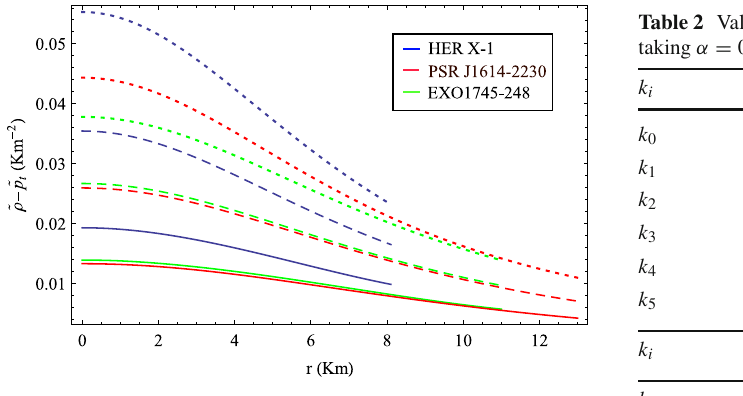
Fig. 14 Radial variation of ˜ ρ − ˜ p t for different compact objects as indicated in the figure. Here plots with solid, dashed and dotted lines correspond to D = 4 , 5 and 6 respectively. To obtain the plots we choose (i) α = 0 . 4, γ = 0 . 45 when D = 4; α = 0 . 3, γ = 0 . 25 when D = 5 and α = 0 . 25, γ = 0 . 2 when D = 6 for HER X-1, (ii) α = 0 . 4, γ = 0 . 5 when D = 4; α = 0 . 3, γ = 0 . 25 when D = 5 and α = 0 . 2, γ = 0 . 15 when D = 6 for PSR J1614-2230, (iii) α = 0 . 4, γ = 0 . 5 when D = 4; α = 0 . 3, γ = 0 . 2 when D = 5 and α = 0 . 2, γ = 0 . 25 when D = 6 for EXO1745-248